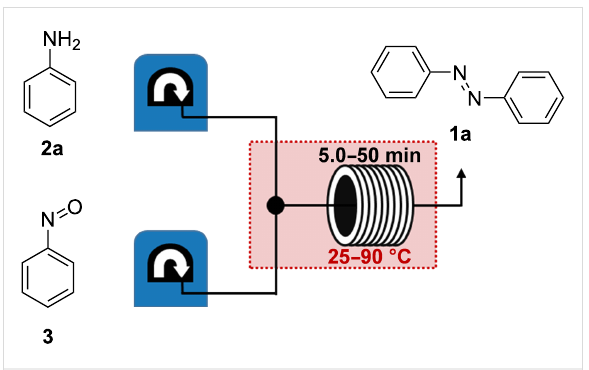
Figure 1: Flow setup for optimization of the Baeyer–Mills reaction with aniline ( 2a ) and nitrosobenzene ( 3 ). In this setup the temperature of the tube reactor as well as the residence time can be individually varied (Figure